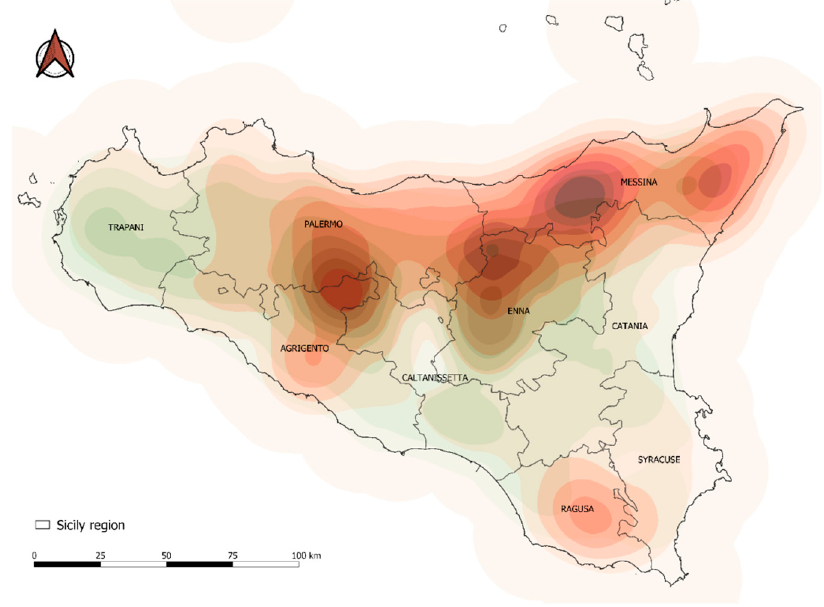
Figure 10. Heatmap obtained by overlapping data on sheep farms and sheep number, at provincial level.